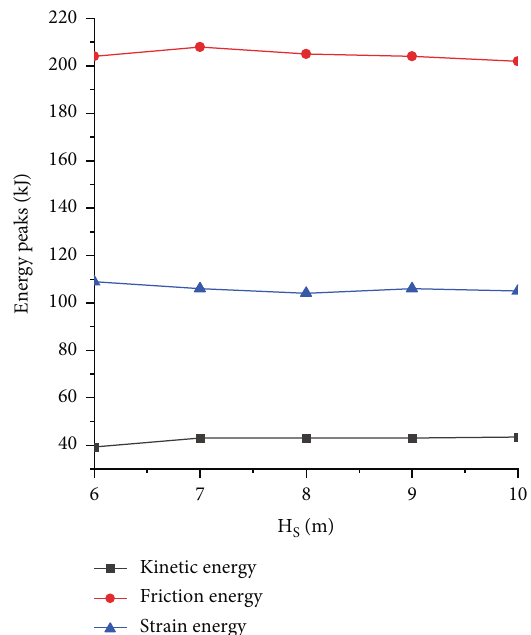
Figure 18: Curves of peak energy versus H